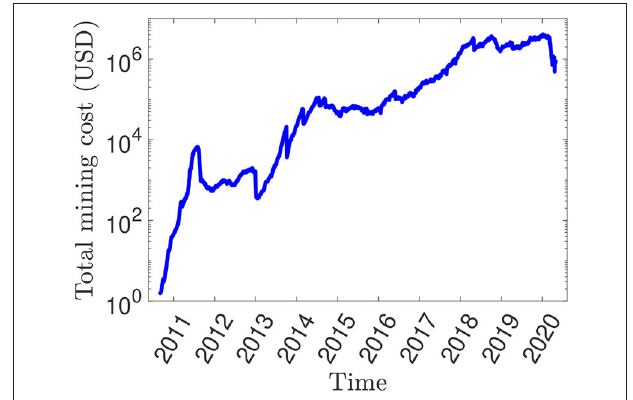
FIGURE 4 | Total daily mining cost C t , reported in USD, estimated by using Equation (4).